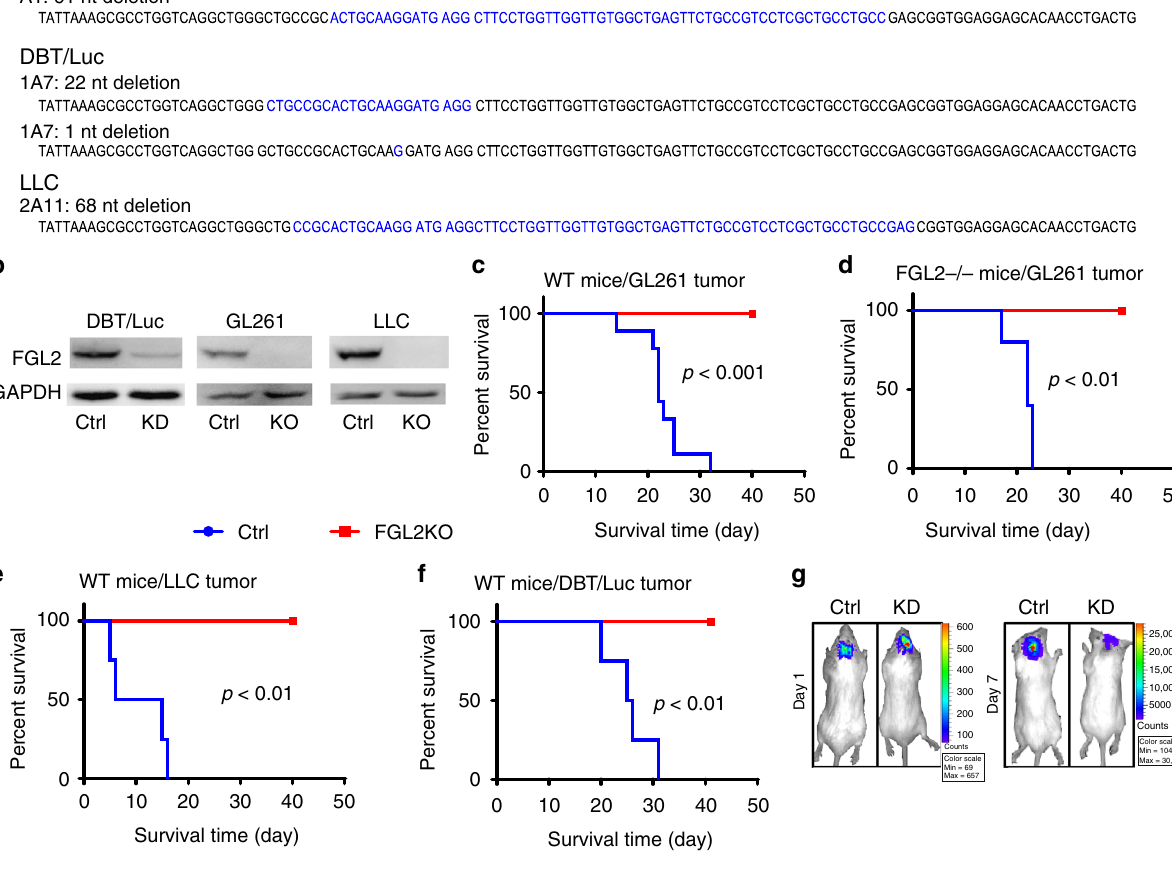
Fig. 2 FGL2 knockout in tumor cells abolishes tumor progression. a Results of DNA fragment deletion in FGL2 exon 1 in individual clones were validated by gene sequencing. Paired gRNAs were designed to excise exon 1 at the mouse FGL2 locus. Individual clones isolated from cells transfected with gRNAs were assayed for deletions and inversions by RT-PCR. b Expression level of FGL2 in three tumor-cell lines, control (Ctrl) and FGL2-knockout (KO) or knockdown (KD) tumor cells, was detected by western blotting. The western blots shown represent three independent experiments. c Survival curve of wild-type (WT) immunocompetent C57BL/6 mice implanted with GL261- Ctrl or GL261- FGL2KO tumor cells (5 × 10 4 cells per mouse; n = 9 per group). d Survival curve of FGL2 − / − mice implanted with GL261- Ctrl or GL261- FGL2KO tumor cells (5 × 10 4 cells per mouse; n = 5/group). e Survival curve of WT immunocompetent C57BL/6 mice implanted with Lewis lung cancer (LLC)- Ctrl or LLC- FGL2KO tumor cells (5 × 10 4 cells per mouse; n = 4 per group). f Survival curve of WT immunocompetent BALB/C mice implanted with mouse astrocytoma (DBT)- Ctrl cells or DBT- FGL2KD tumor cells (5 × 10 4 cells per mouse; n = 4